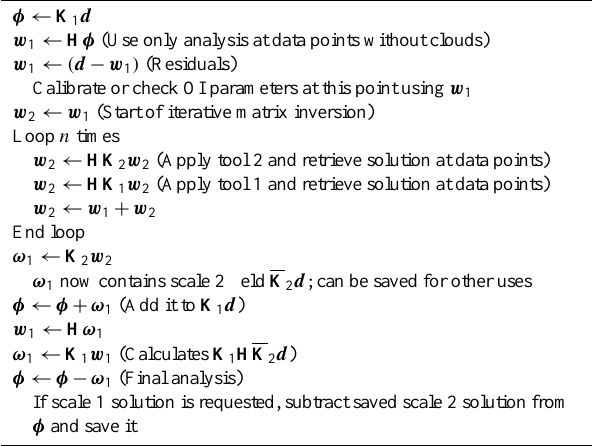
Algorithm 2. Combination of two analysis tools for an optimal interpo-